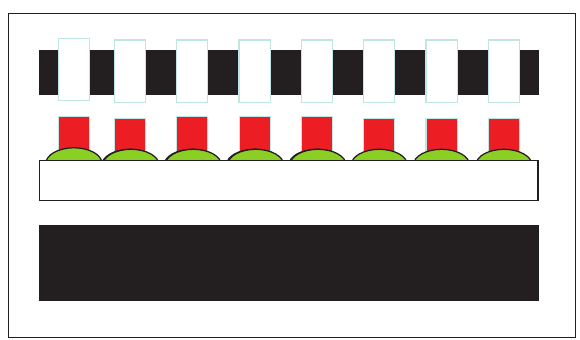
Figure 5: A schematic of the pressurized water Cherenkov